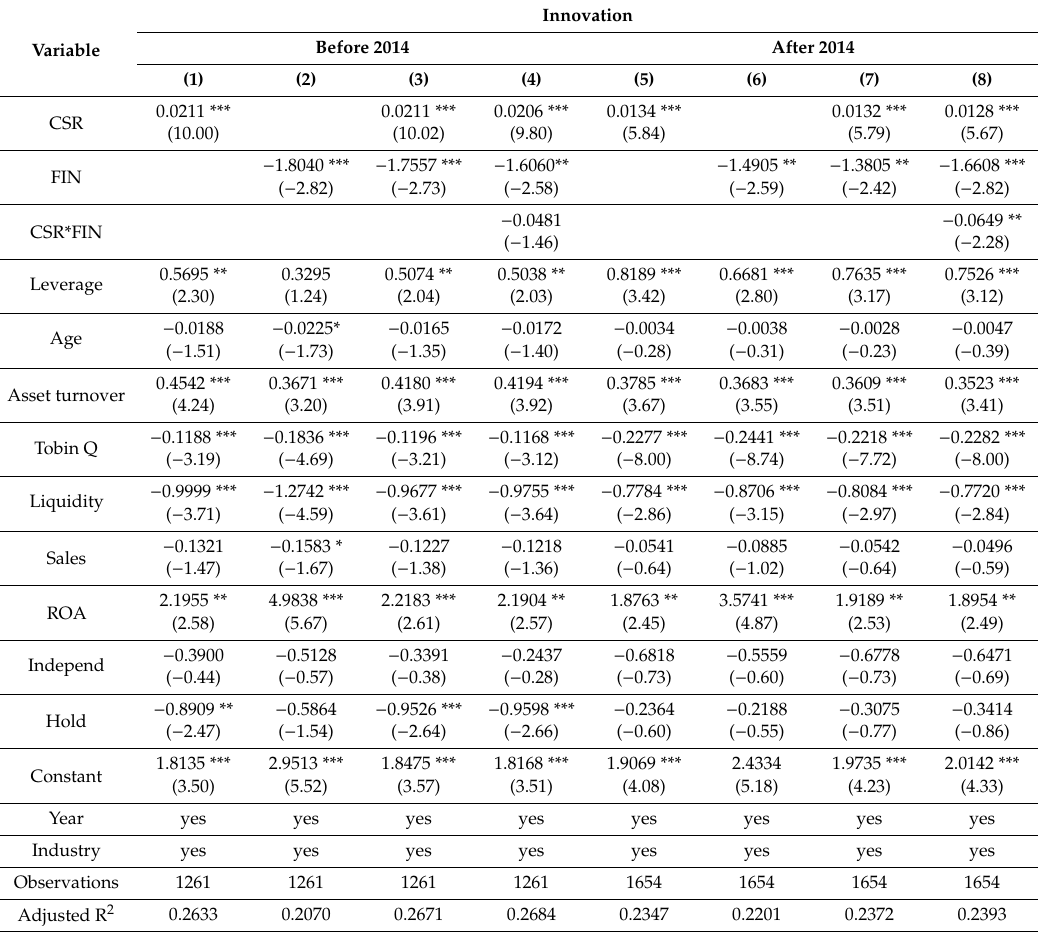
Table 7. Regression results of di ff erent